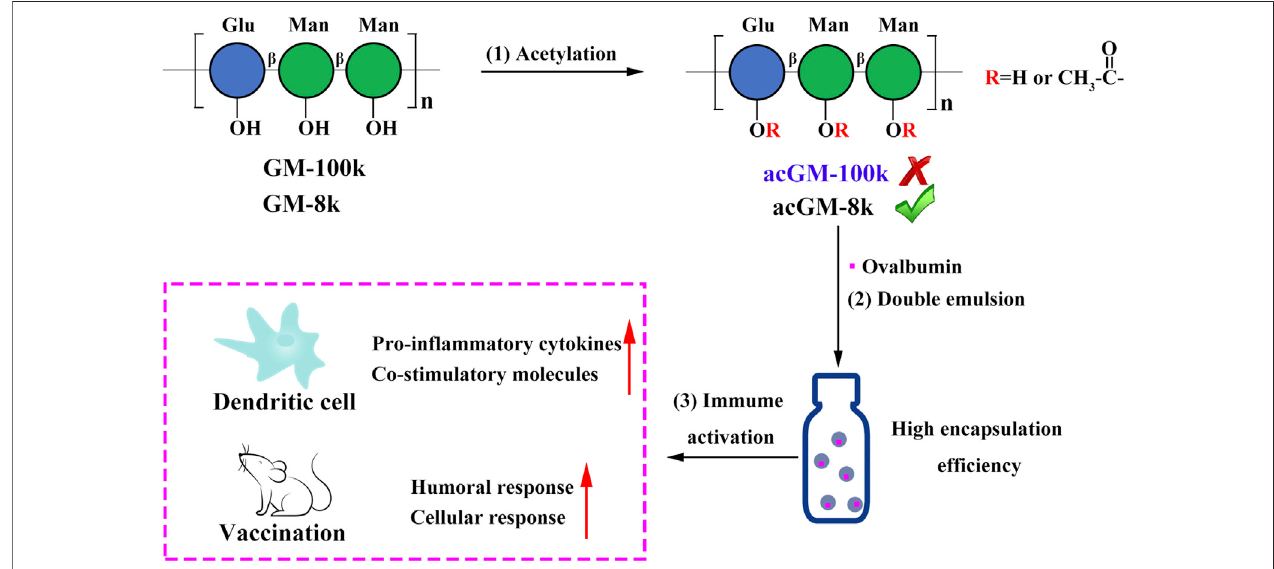
FIGURE 1 | Schematic illustration of designing a self-adjuvant carrier for antigen delivery. (1) Acetylation of glucomannans (GM) with different molecular weights (100 and 8 kDa). (2) Encapsulation of ovalbumin (OVA) into acetyl GM (acGM) through a double-emulsion method. (3) Evaluation of the OVA-loaded acGM-8k NPs (OVA@acGM-8k NPs) in promoting the humoral and cellular immunity in mice.